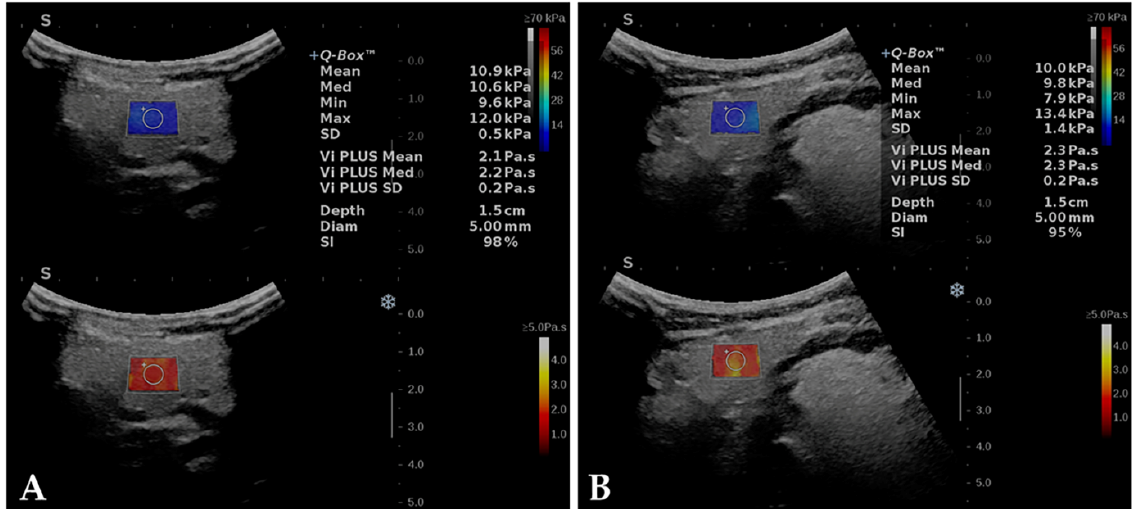
Figure 1. The basal assessment of the parotid gland ( A ) and submandibular gland ( B ) in a healthy subject using 2D-SWE.PLUS (up) and Vi.PLUS (down) modes, simultaneously engaged. A color-coded map is displayed in the 2D-SWE.PLUS box (range 0 to 70 kPa), colors on top of the bar (red) represent high stiffness, while colors on the bottom (blue) represent low stiffness. A color-coded map (range 0 to 5 Pa.s) is also displayed in the Vi.PLUS box, high viscosity is represented by white-yellow colors, while low viscosity is depicted in red.